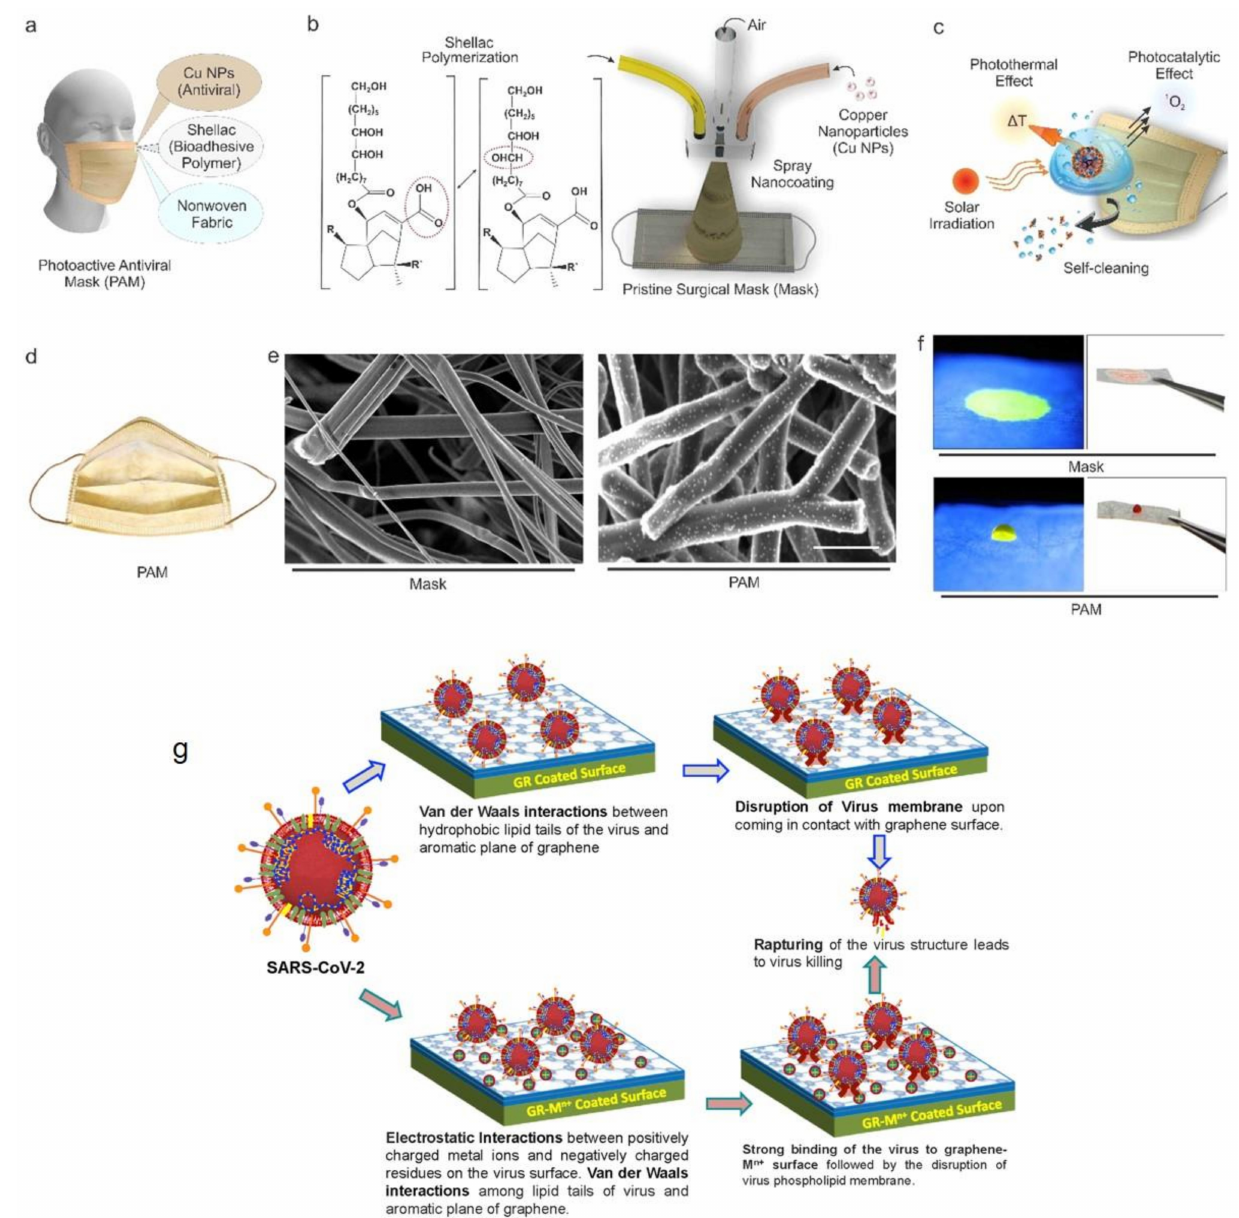
Figure 9. Schematic illustration of: ( a ) the antiviral nanohybrid coated surgical masks, ( b ) the dual-channel spray coating process on the nonwoven fibers of the surgical mask, whereby the Cu nanoparticle suspension and shellac are mixed and sprayed via the compressed N 2 air channel, and ( c ) the solar light driven inactivation of the viruses available in the respiratory droplets. ( d ) Camera image of the photoactive antiviral mask (PAM). ( e ) SEM images show the morphology of propylene nonwoven fibers ( left ) in the commercial surgical mask and the nanohybrid-coated nonwoven fibers in the same mask ( right ). (Scale bar represents 10 µ m). ( f ) Camera images of a dyed water droplet deposited on the uncoated mask and PAM after one hour. Reproduced with permission [154], Copyright 2021, American Chemical Society. ( g ) Schematic illustration of likely interactions between SARS-CoV-2 and graphene (GR) and GR nanohybrids comprising GR-metal ion, leading to virus inactivation on the coated surfaces. Reproduced with permission [167], Copyright 2020,